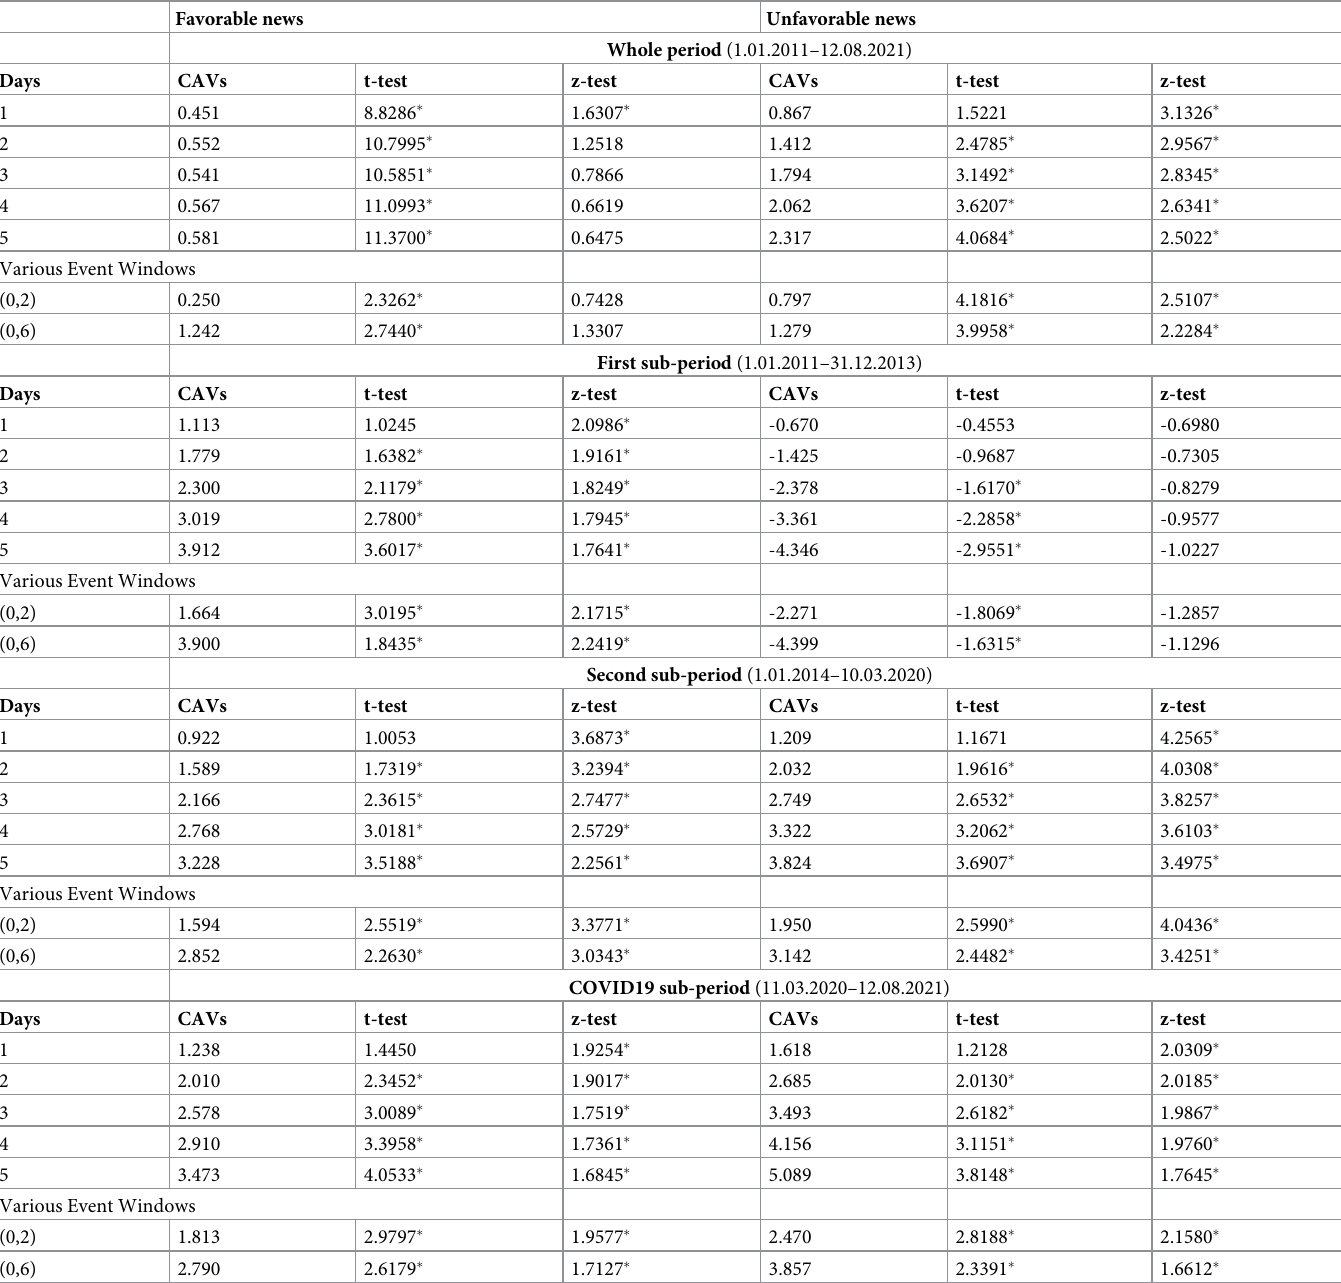
Table 8. Post-event CAVs after unexpected favorable and unfavorable events, for the four analyzed periods. Favorable